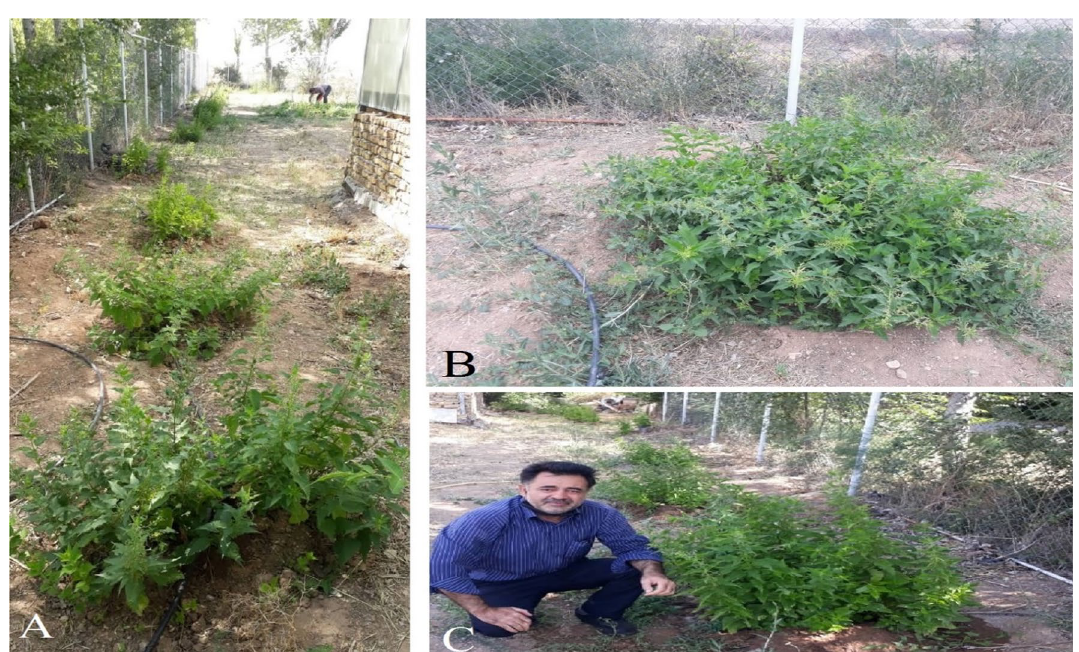
Figure 3. Field experimental studies on Nettles ( A ), a developed 2-year nettle plant ( B ) and Ali Ammarellou, the researcher and author on the Live Collection of Iranian Nettles (LCINs). Shrubs are planted in the field with similar soil conditions at intervals of three meters having irrigation system in